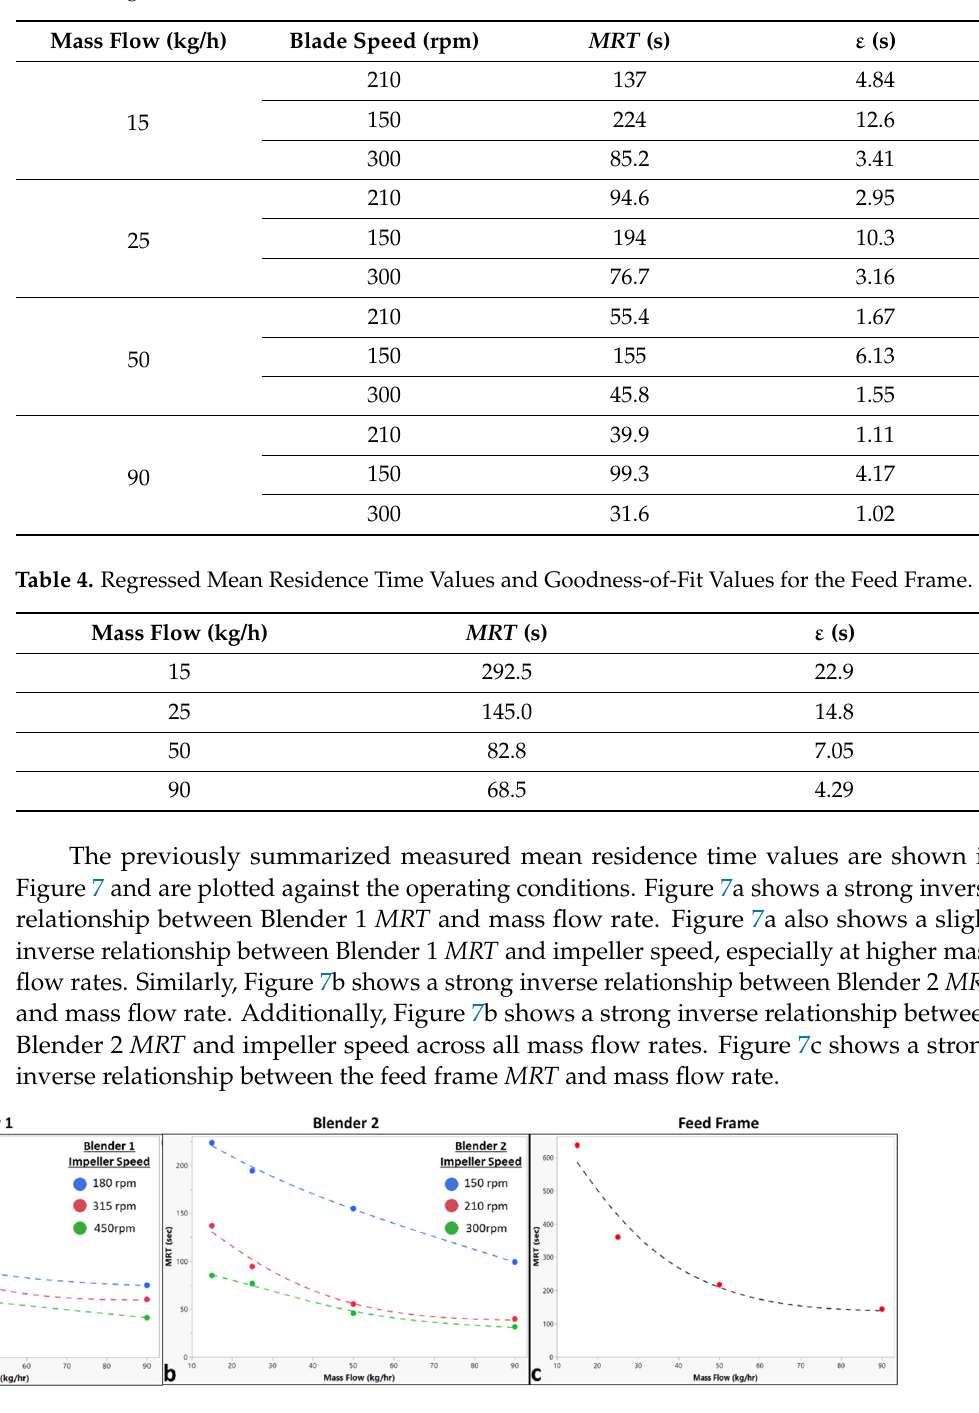
Figure 7. Plots of the measured mean residence time for each blending unit. ( a ) Plot for the measured Blender 1 mean residence time versus the total system mass flow rate with series at Blender 1 impeller speed. ( b ) Plot for the measured Blender 2 mean residence time versus the total system mass flow rate with series at Blender 2 impeller speed. ( c ) Plot for the measured feed frame mean residence time versus the total system mass flow rate.